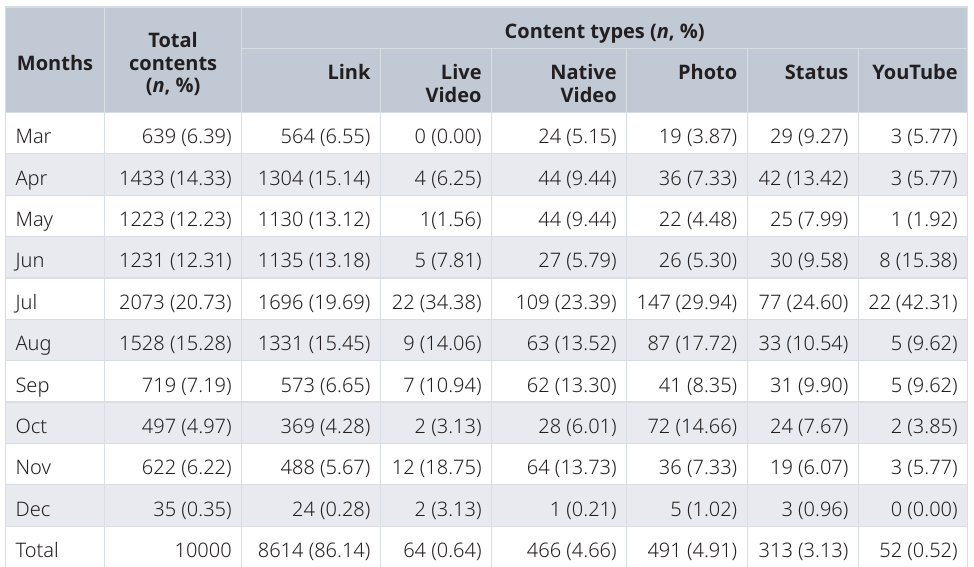
Table 1. Content types and their